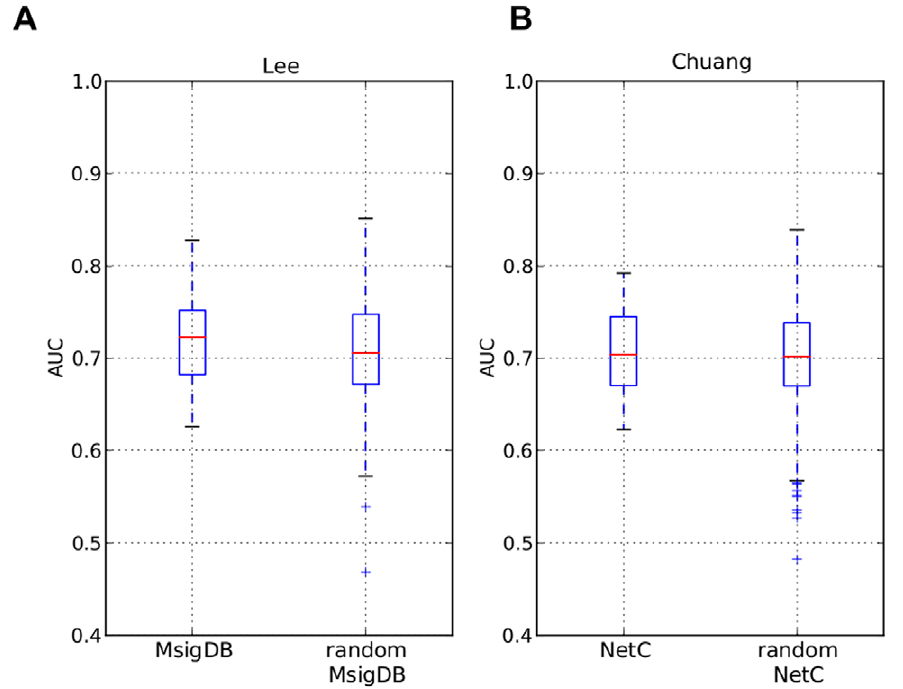
Figure 7. The effect of randomized secondary data sources. Left: AUC values obtained with the feature extraction method Lee on real and randomized MsigDB pathways. Right: AUC values obtained with the feature extraction method Chuang on real and randomized PPI networks.